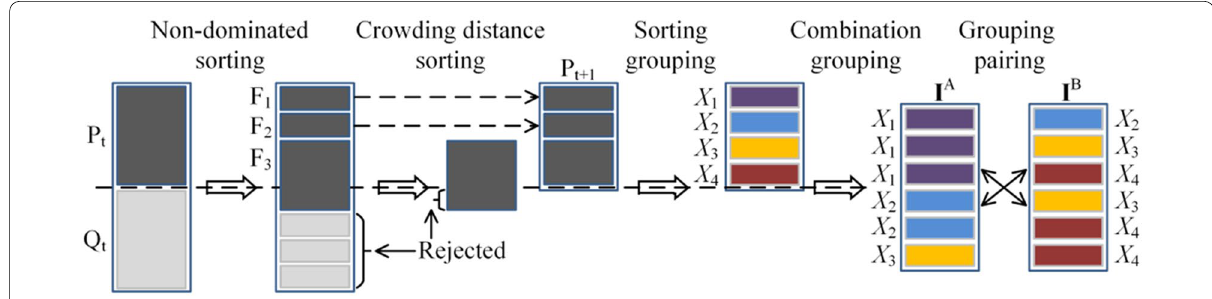
Figure 1 Schematic of the RGS operation